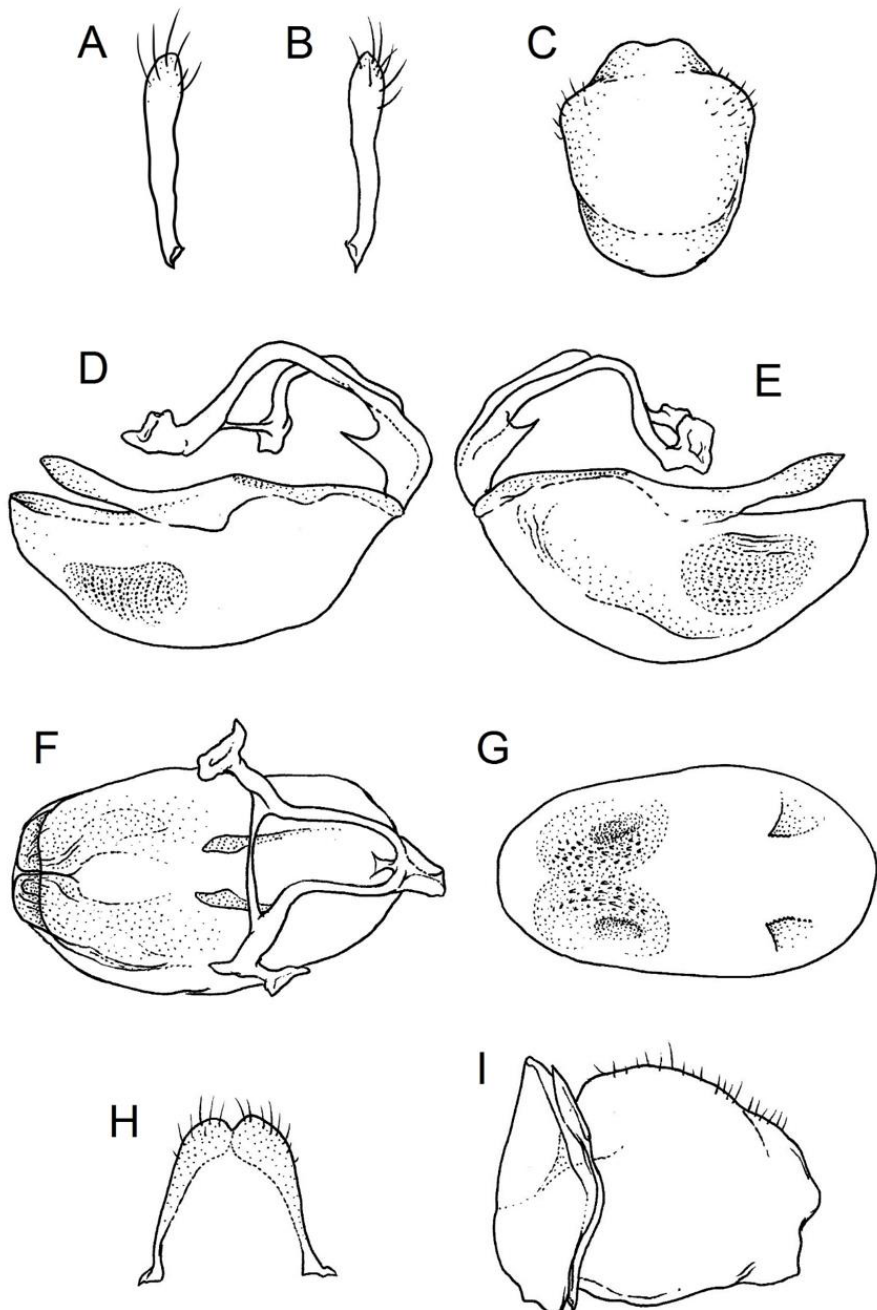
Figure 42. Phonoctonus grandis Signoret, 1860: ( A ) left paramere; ( B ) right paramere; ( C ) pygophore, ventral view; ( D ) aedeagus, right lateral view; ( E ) aedeagus, left lateral view; ( F ) aedeagus, dorsal view; ( G ) aedeagus, ventral view; ( H ) styloids, outer view; and ( I ) gonocoxite of abdominal segment VIII. Thorax : Anterior pronotal lobe of pronotum orange or red with paler collar (Figure 16G). Transversal sutura of pronotum black or partially black (middle portion). Posterior pronotal lobe orange with more intensive colour on the posterior and lateral areas. Prosternum is orange or red. If the prosternum is orange, the proepisternum is red (paralectotype); if the prosternum is red, the proepimeron is orange (lectotype). Mesosternum is orange with reddish lateral portions or is entirely red. Metasternum is orange with reddish middle portion of the posterior margin or entirely red. Mesoepisternum, mesoepimeron,